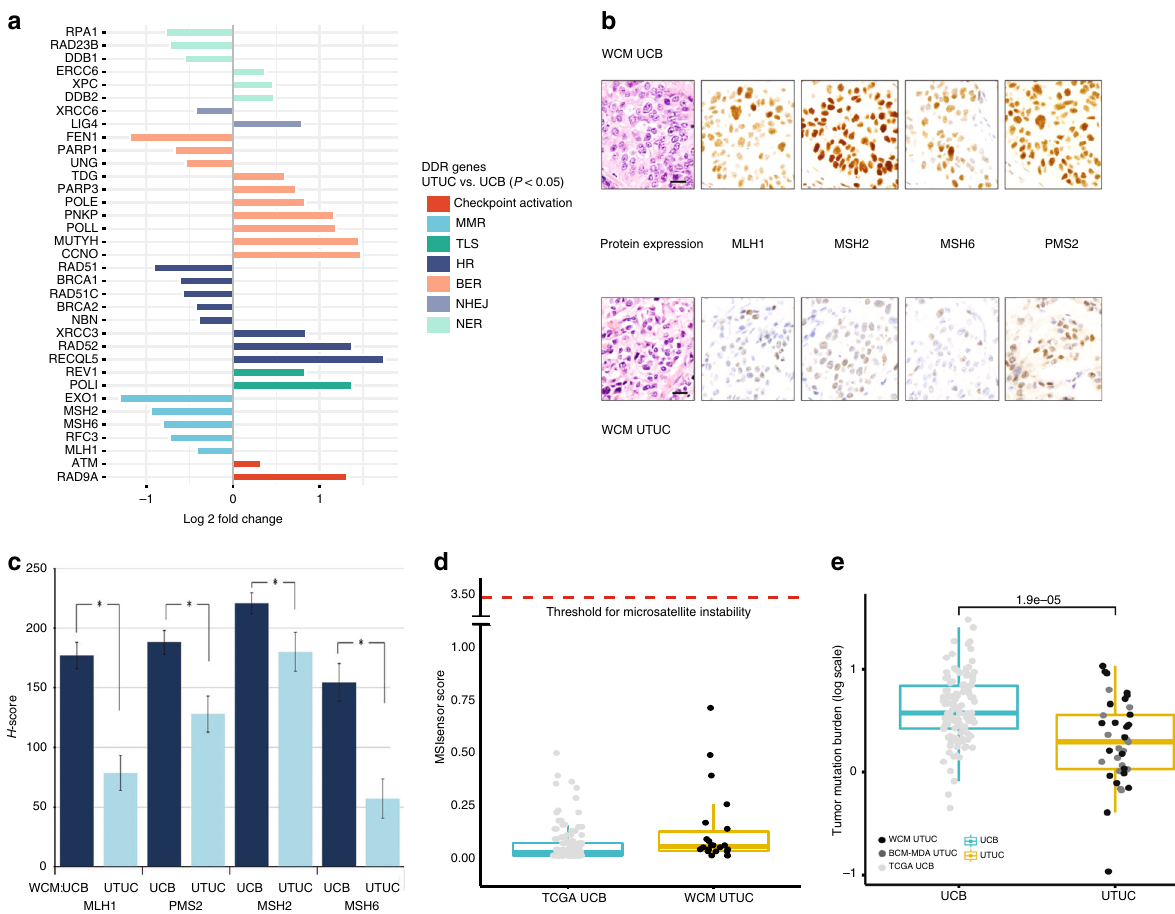
Fig. 2 UTUC is characterized by decreased expression of canonical MMR proteins. a Comparative histogram of DNA damage response (DDR) genes with statistically signi fi cant differential expression (log 2 fold) highlighting signi fi cantly lower expression of mismatch repair (MMR) pathway genes ( MLH1, MSH2, MSH6, RFC3, EXO1 ) in WCM UTUC compared to TCGA UCB (one-way ANOVA log2FC adjusted P ≤ 0.05). b Representative micrographs (magni fi cation ×400) showing lower expression of MMR proteins in a UTUC tumor compared to a UCB tumor by immunohistochemistry. Scale bars represent 25 µ M. c Mean H -scores of MMR proteins are signi fi cantly lower in WCM UTUC tumors compared to WCM UCB tumors. Error bars show standard deviation (S.D.) for each MMR protein. Asterisks indicate statistically signi fi cant changes in paired comparison ( t -test P < 0.05). d Mean microsatellite instability (MSI) score is below the threshold of 3.5 in both WCM UTUC and TCGA UCB tumors. e Mean total mutational burden (TMB), expressed in log scale is lower in UTUC (WCM, BCM-MDA) compared to TCGA UCB tumors (Mann – Whitney test P = 1.9 × 10 − 5 ). The horizontal lines within the boxes in the boxplots indicate the mean, boundaries of the boxes indicate the 25th-percentile and 75th-percentile, and the whiskers indicate